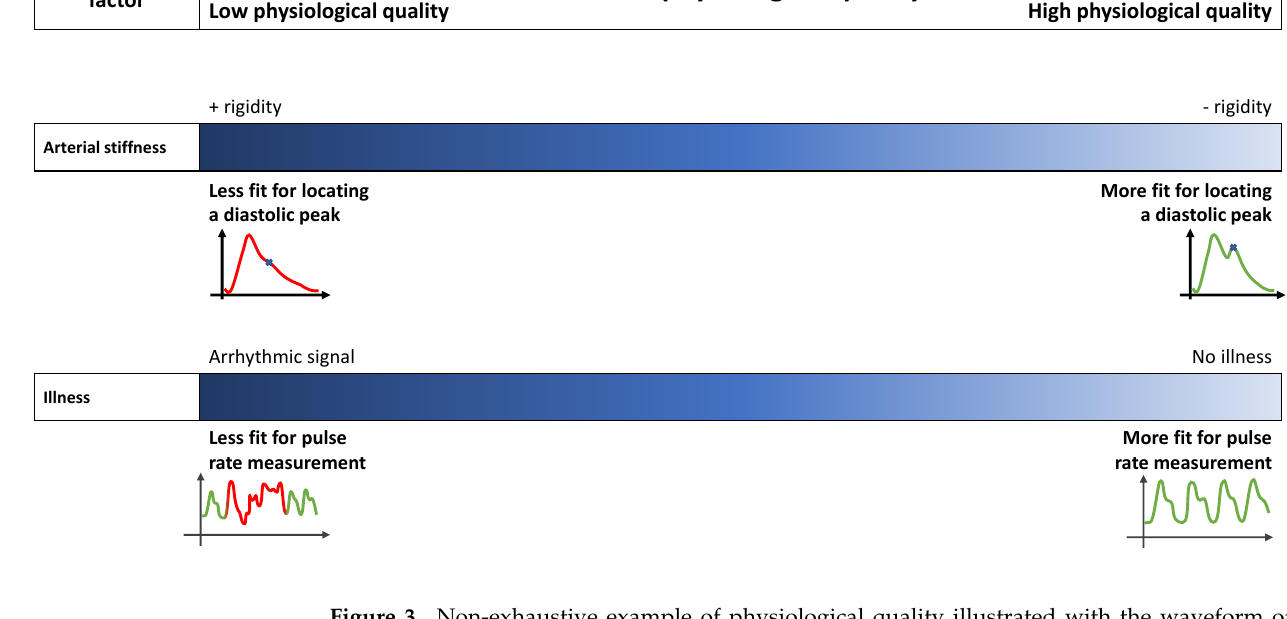
Figure 3. Non-exhaustive example of physiological quality illustrated with the waveform of a fingertip contact PPG. The physiological factors presented here are not measurement perturbations. Here, the case of optimal measurement conditions with a perfect sensor is represented. The signal reflects the variation in blood volume. However, the shape of the obtained signal cannot be used for its